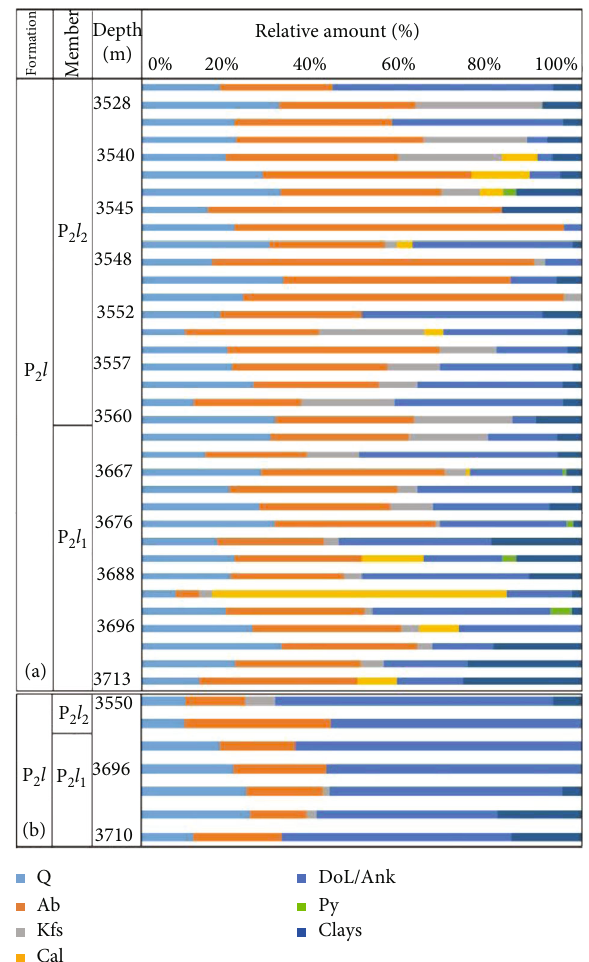
Figure 2: Longitudinal distribution characteristics of the main mineral components in the upper and lower sweet spots of well J10025: clastic rocks (a) and carbonate rocks